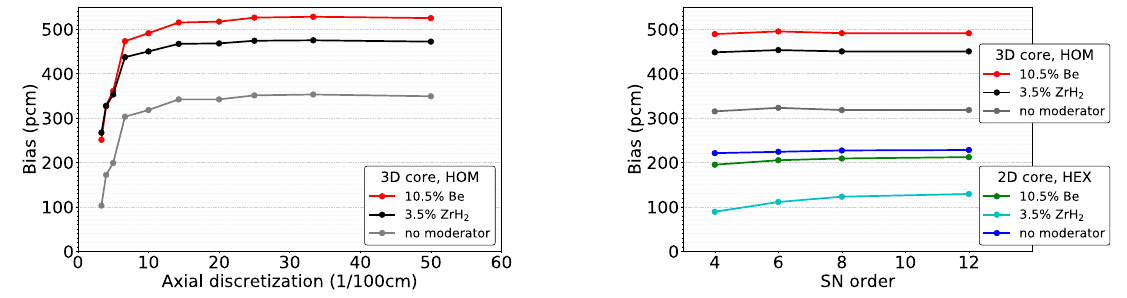
Figure 5: Bias of A3 calculation compared to T4 reference